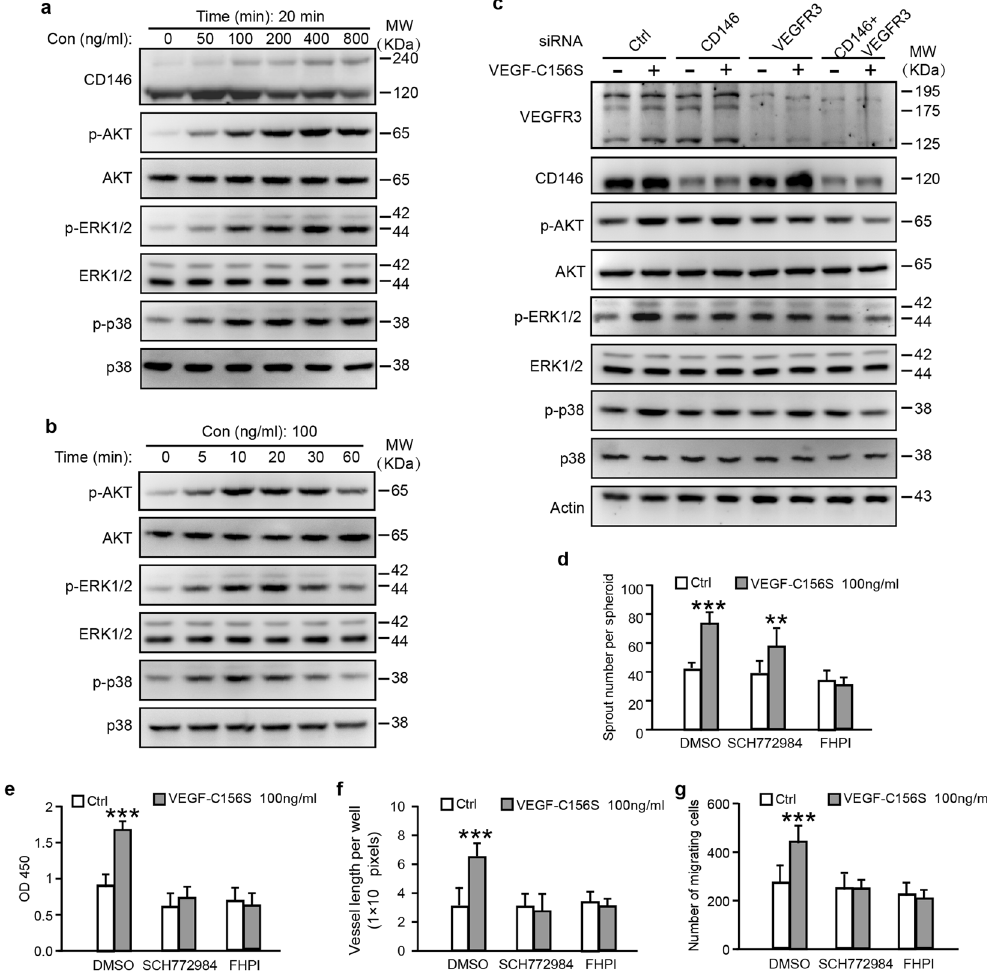
Figure 2. VEGF-C elicitation of different signaling cascades downstream of CD146 or VEGFR-3. ( a , b ) Dose and time effect of VEGF-C156S on HDLEC cells. Serum-starved cells were treated with VEGF-C156S for 20 min at different concentrations in ( a ) or with 100 ng/ml of VEGF-C156S at different time intervals in ( b ). Dimerization of CD146 and phosphorylation and expression of AKT, ERK and p38, elicited from VEGF-C156S, were analyzed by WB. ( c ) HDLEC cells, transfected with siRNA of control, CD146, VEGFR-3 or combination of CD146 and VEGFR-3, were treated with 100 ng/ml of VEGF-C156S for 20 min. ( d – g ) HDLEC cells, pretreated with SCH772984 or FHPI for 72 hr, were subjected to spheroid sprouting assay ( d ), proliferation assay ( e ), tube formation assay ( f ) and transwell migration assay ( g ). VEGF-C156S was applied at the indicated concentration. Data were expressed as means ± SEM from 3 independent experiments (n = 12 in each group of d – g ). Significant difference was determined by Student ’ s t- test ( * P < 0.05; ** P < 0.01; *** P < 0.001; ns, no significant difference). Full-length blots are presented in Supplementary Fig.